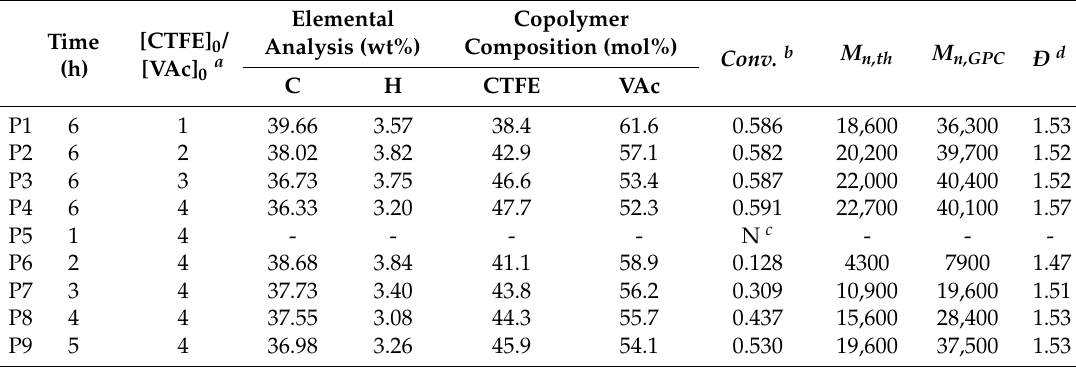
Table 1. Results of Co(acac) 2 -mediated radical copolymerization of CTFE and